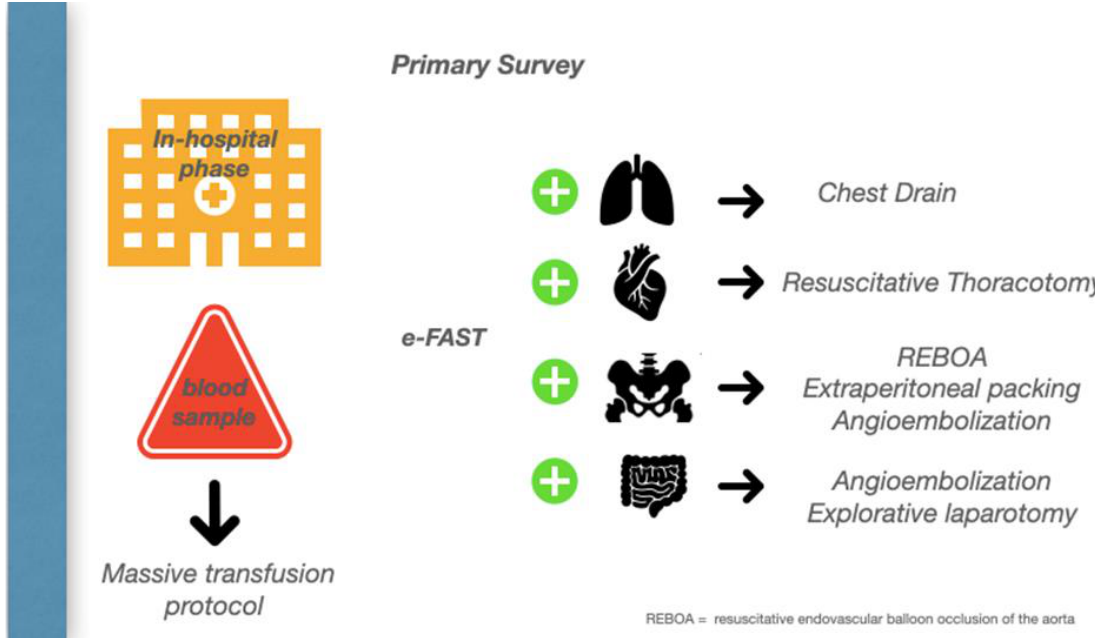
Figure 3. In-hospital Phase.